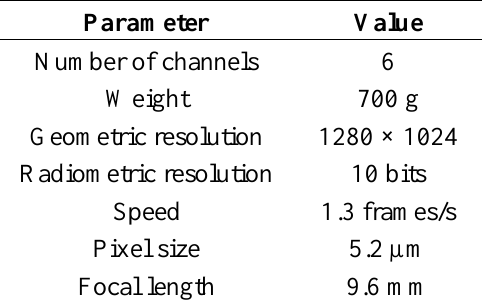
Table 1. Characteristics of the Mini-MCA multispectral